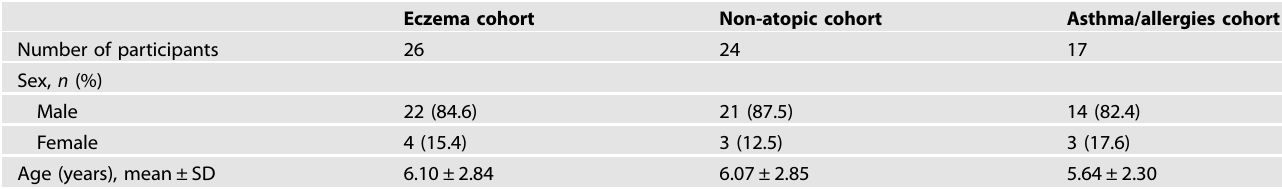
SD standard deviation.